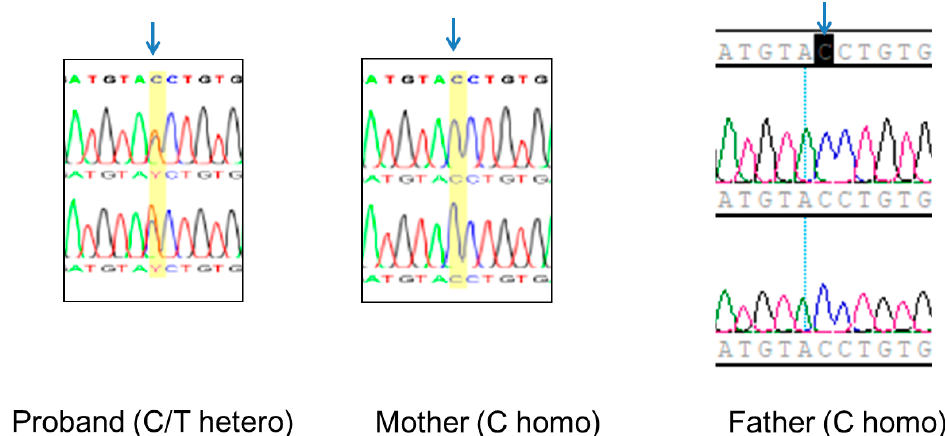
Figure 3. The Sanger sequencing chromatograms of the proband–parents TRIO study for EFTUD2 c.271+1G>A variant showed wild type (C homo) in both parents and single heterozygote (C/T hetero) in the proband. (blue arrow = variant position)